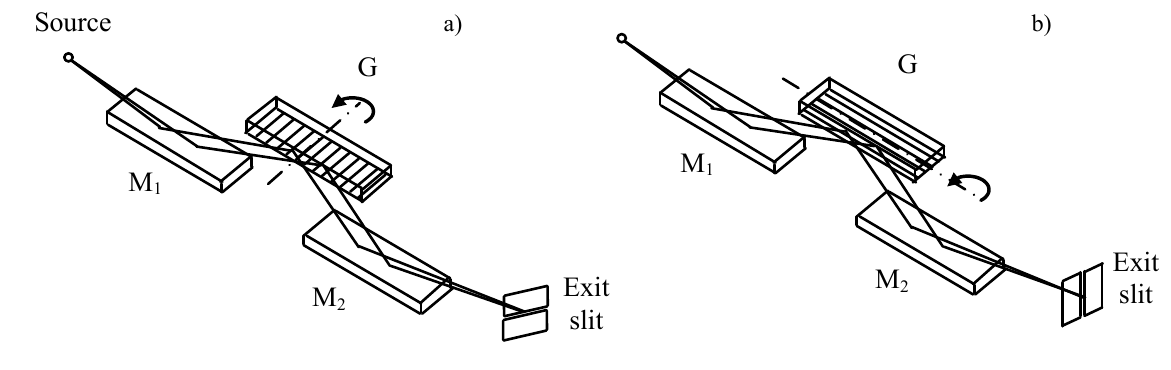
Figure 2. Monochromator with plane gratings: ( a ) CDM; ( b )